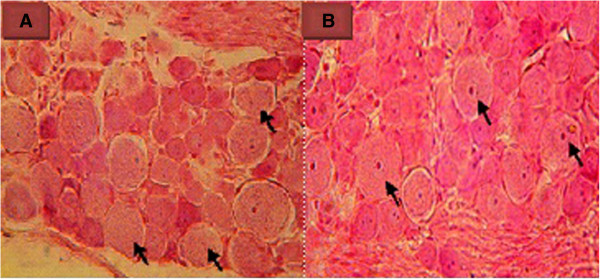
Histopathological evaluation of dorsal Root Ganglion neurons in the treatment and control groups. A: Death of dorsal Root Ganglion (DRG) neurons in the control group that treated with normal saline, there were not nucleolus and nuclei (arrow), (H&G, x400). B: Note that of dorsal Root Ganglion (DRG) neurons in the experimental groups that treated vitamins B12, there were nucleolus and nuclei (arrow), (H&Gx400).